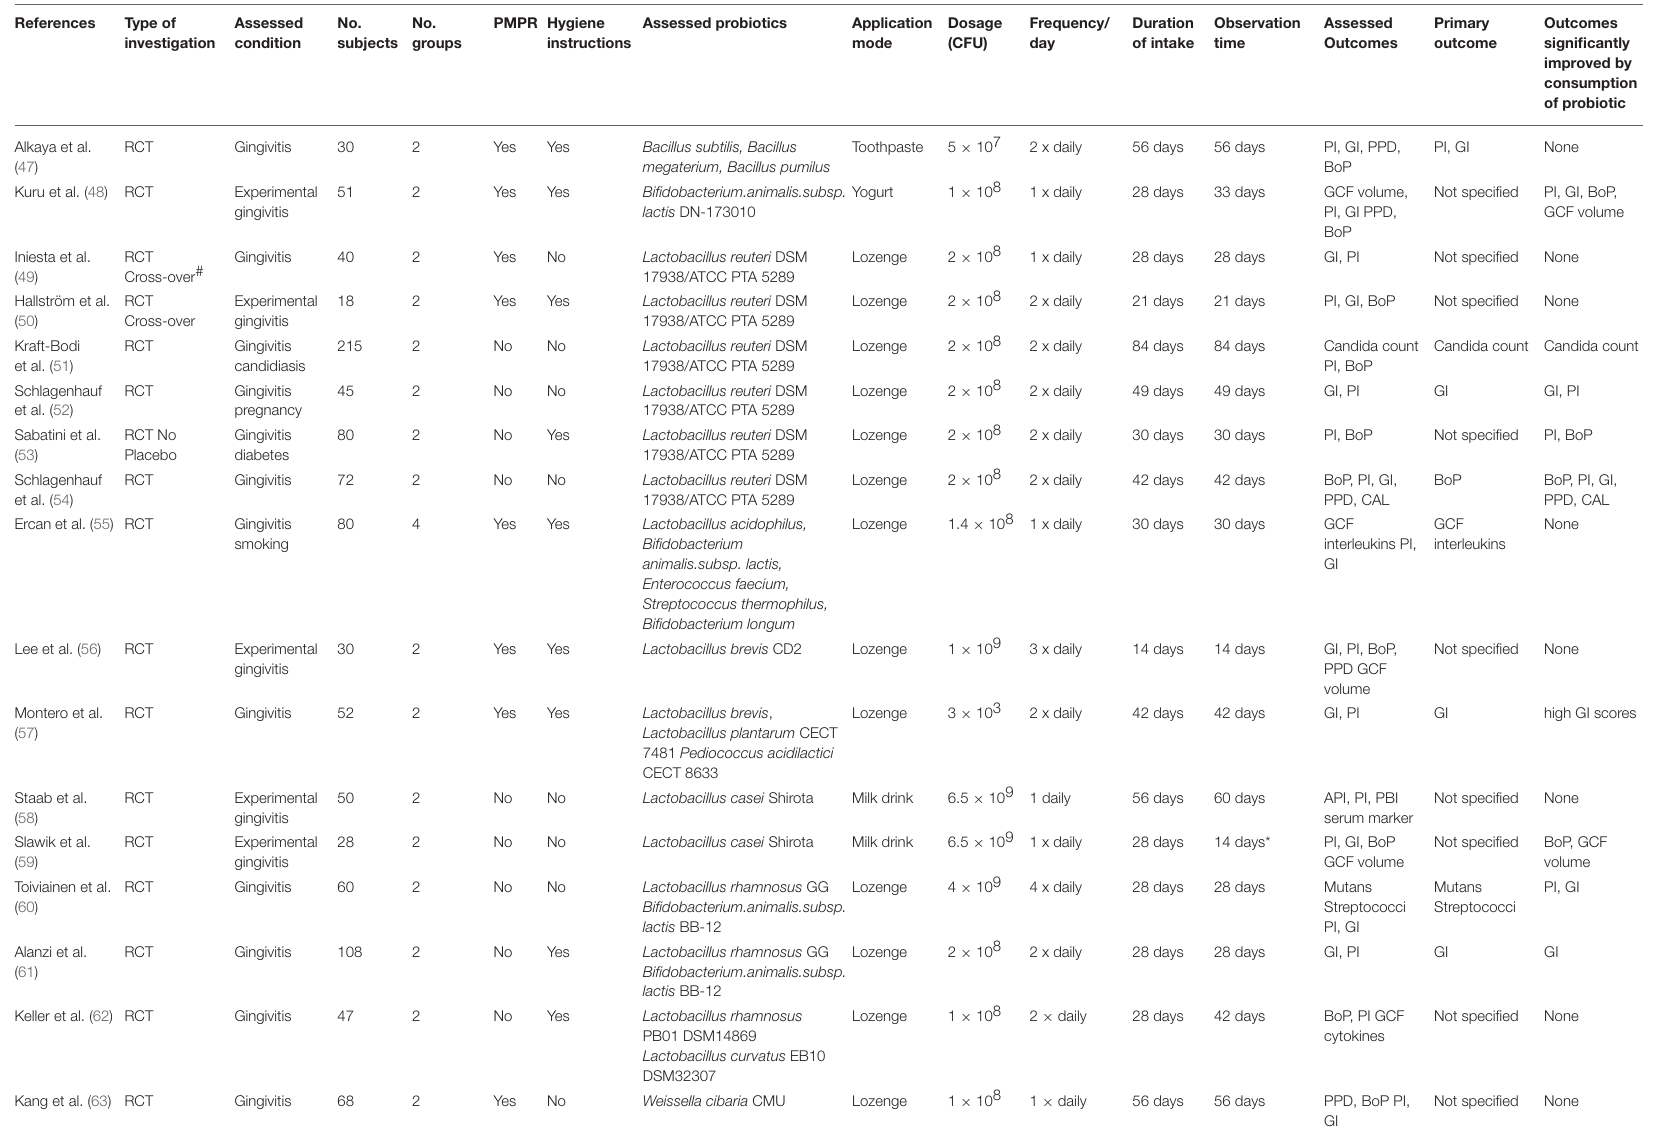
TABLE 1 | Randomized controlled trials evaluating the use of probiotics in the management of